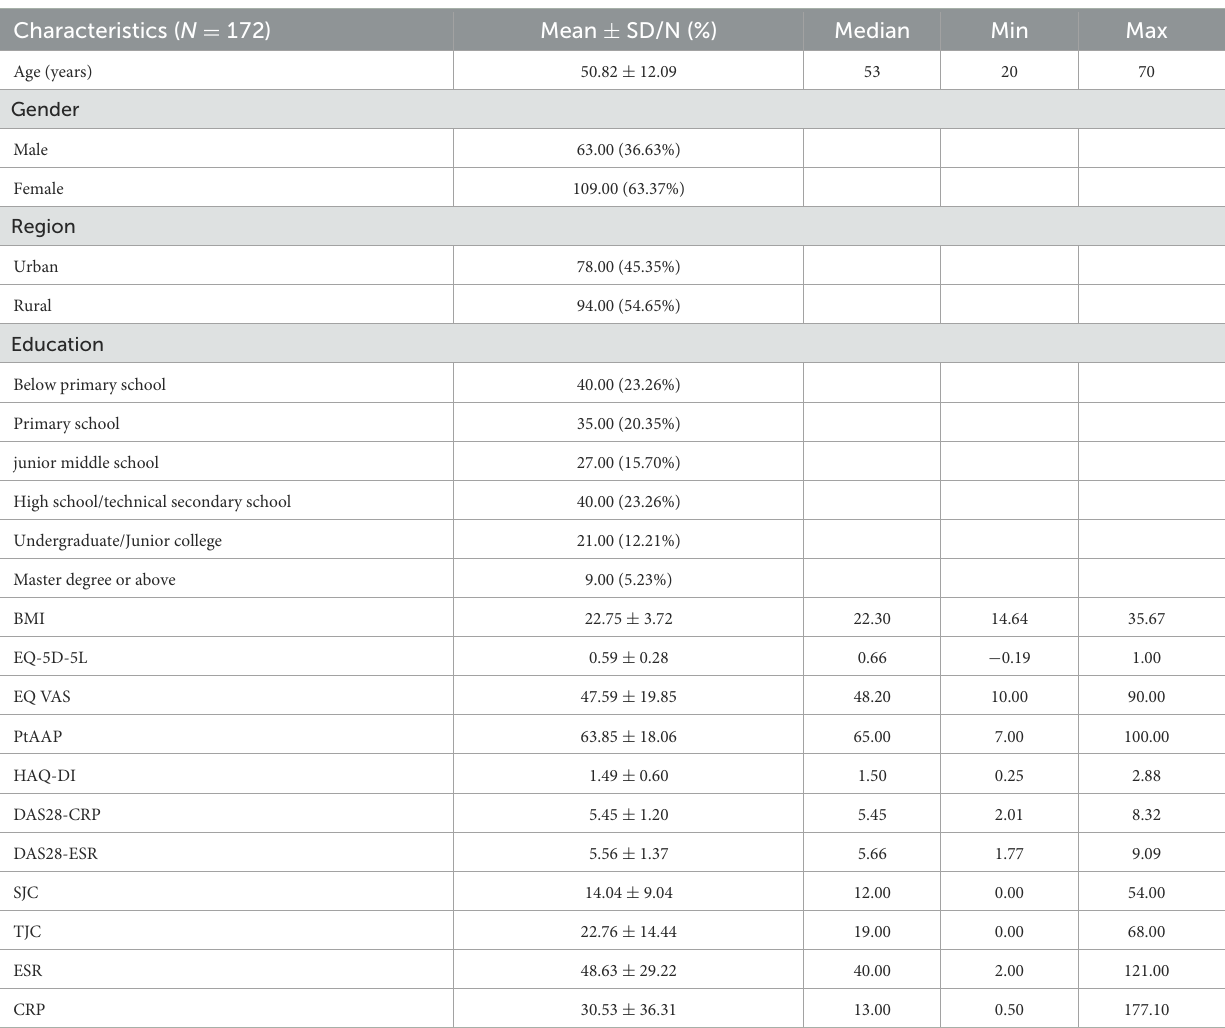
TABLE 2 Socio-demographic characteristics and patient-reported outcomes.